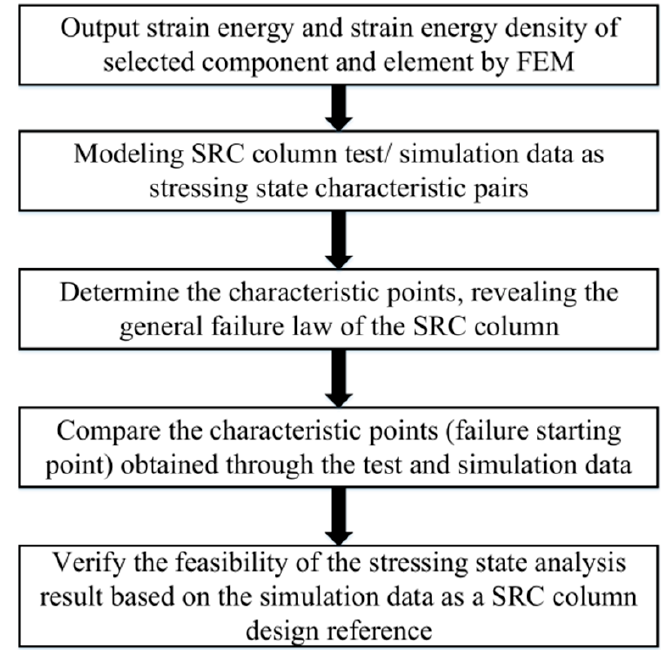
Figure 1. Process of SRC column’s stressing state analysis. IE represents the internal energy of each part output by the post-processing module of the SRC column’s finite element model. The superscripts c, v, and s represent the concrete, vertical steel bar, and spiral steel bar of the SRC column, respectively. The subscript j represents the load step in the process of FEM analysis. As shown in Equations (4) and (5), in order to further reveal the mutation law in the process of stressing state evolution of SRC columns, the first-order characteristic parameters ∆ IE j ,norm and second-order characteristic parameters ∆ 2 IE j ,norm are also defined in this paper to characterize the stressing state evolution of SRC